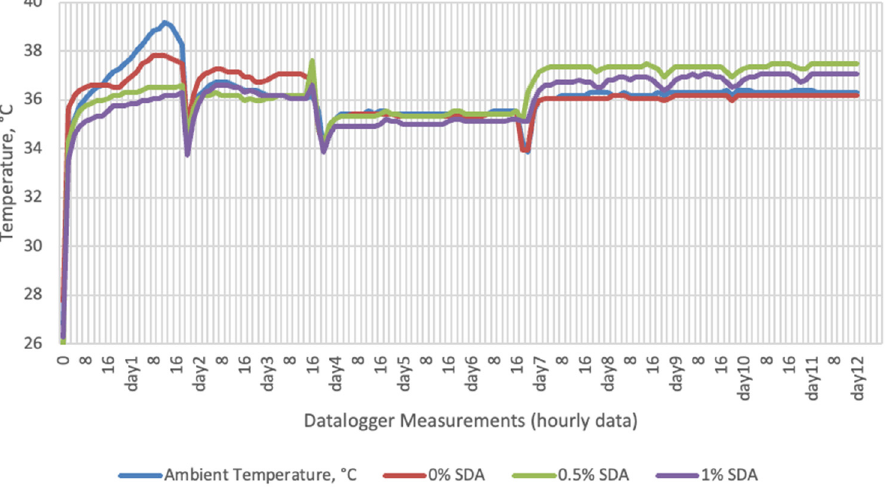
Figure 4. Temperature changes of SDA supplemented groups stored at incubator conditions for 12 days (Ambient temperatures of incubator conditions: 35–37 °C; 26% Humidity).